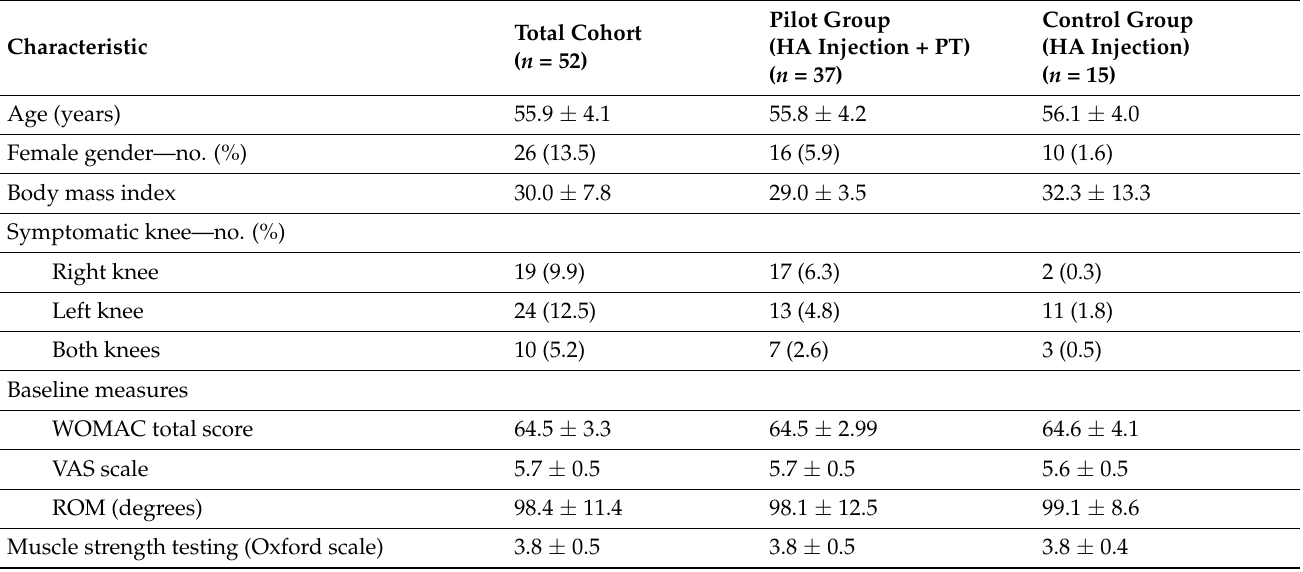
Table 1. Baseline characteristics of the patients *.